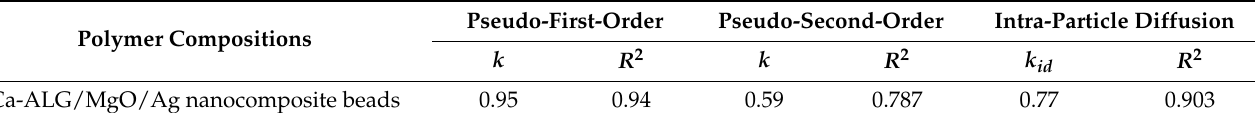
Table 1. Kinetic parameters: pseudo-first-order kinetics, pseudo-second-order kinetics, and intra- particle diffusion model of Direct Red 83 dye degradation.